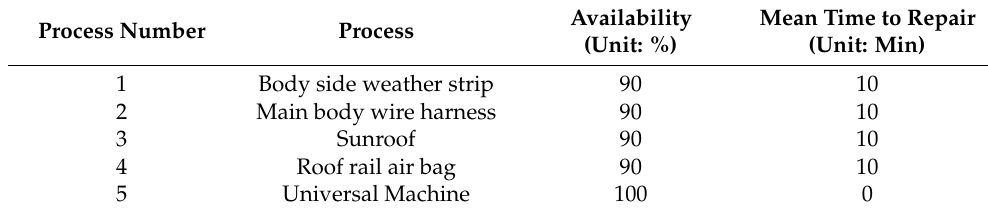
Figure 12. Re-entrant production lines with same OF but different RF . Table 6. Availability and mean time to repair settings of each station in Case